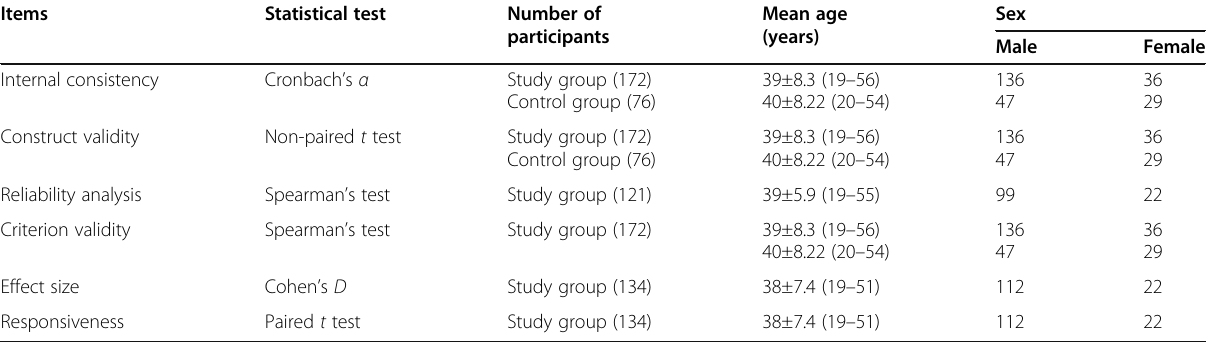
Table 1 Demographics and the related statistics of the study and control